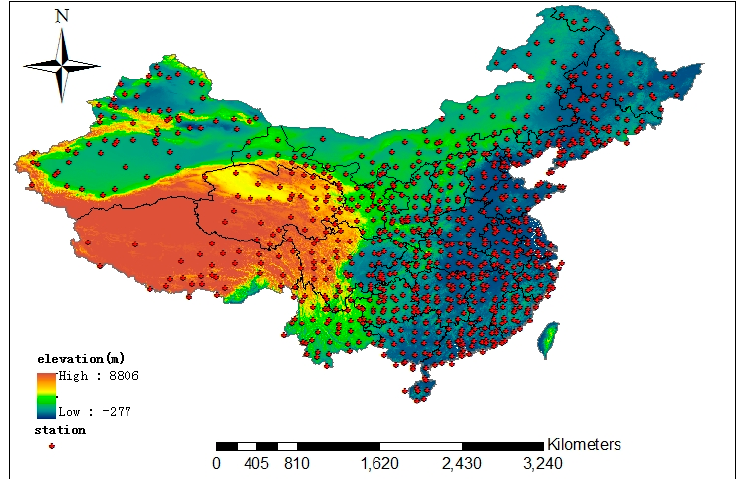
Figure 1. Site distribution and topography.